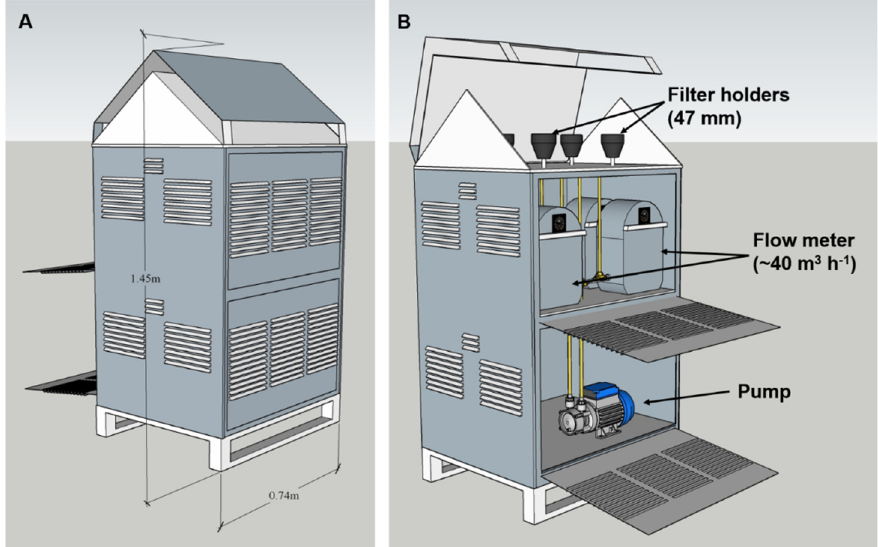
Figure 1. A schematic illustration of the custom-made air volume sampler used to collect dust and corresponding airborne microbes on the rooftop of the IOLR (~20 m above sea level) between 2015–2018. Dust/aerosol particles in the air were vacuum pumped at ~40 m 3 h − 1 for 7–63 h onto sterile 47 mm polycarbonate filters.